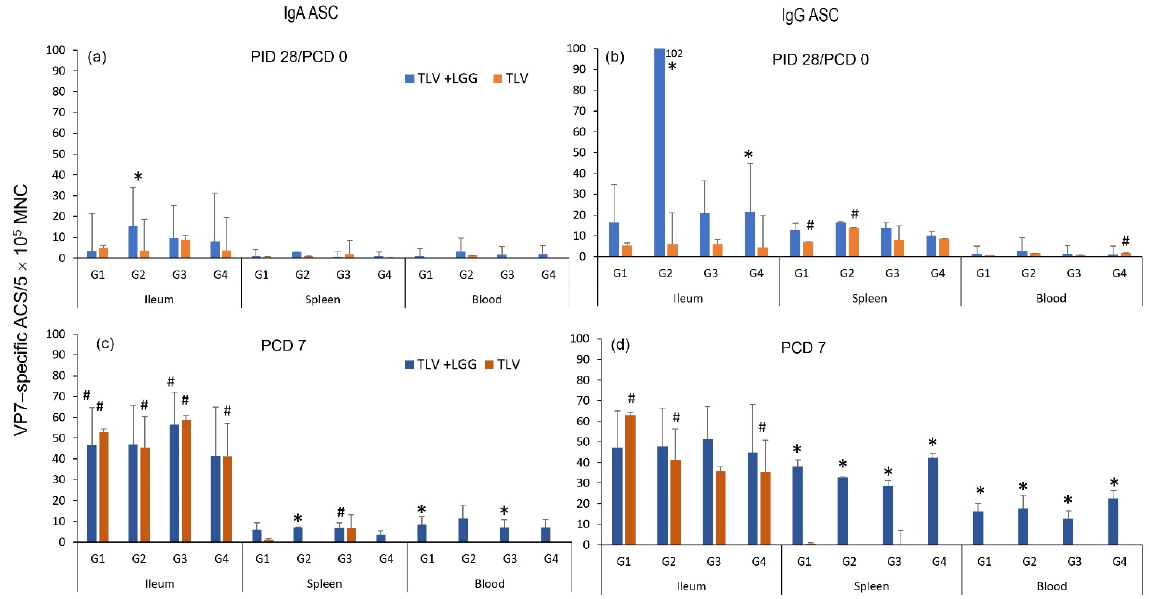
Figure 6. IgA and IgG VP7–specific ASC responses in the intestinal and systemic lymphoid tissues prechallenge (PID 28/PCD 0) (a and b) and postchallenge (PCD 7) (c and d). # Indicates a significant difference between PID 28/PCD 0 and PCD 7 for each vaccine group in each tissue for each VP7 G–type * Indicates a significant difference between TLV+LGG and TLV groups for the same VP7 type in the same tissue and timepoint (Kruskal–Wallis non–parametric rank sum test, p < 0.05). Pigs in the LGG and mock control groups did not develop VP7–specific ASC responses (Table S1).